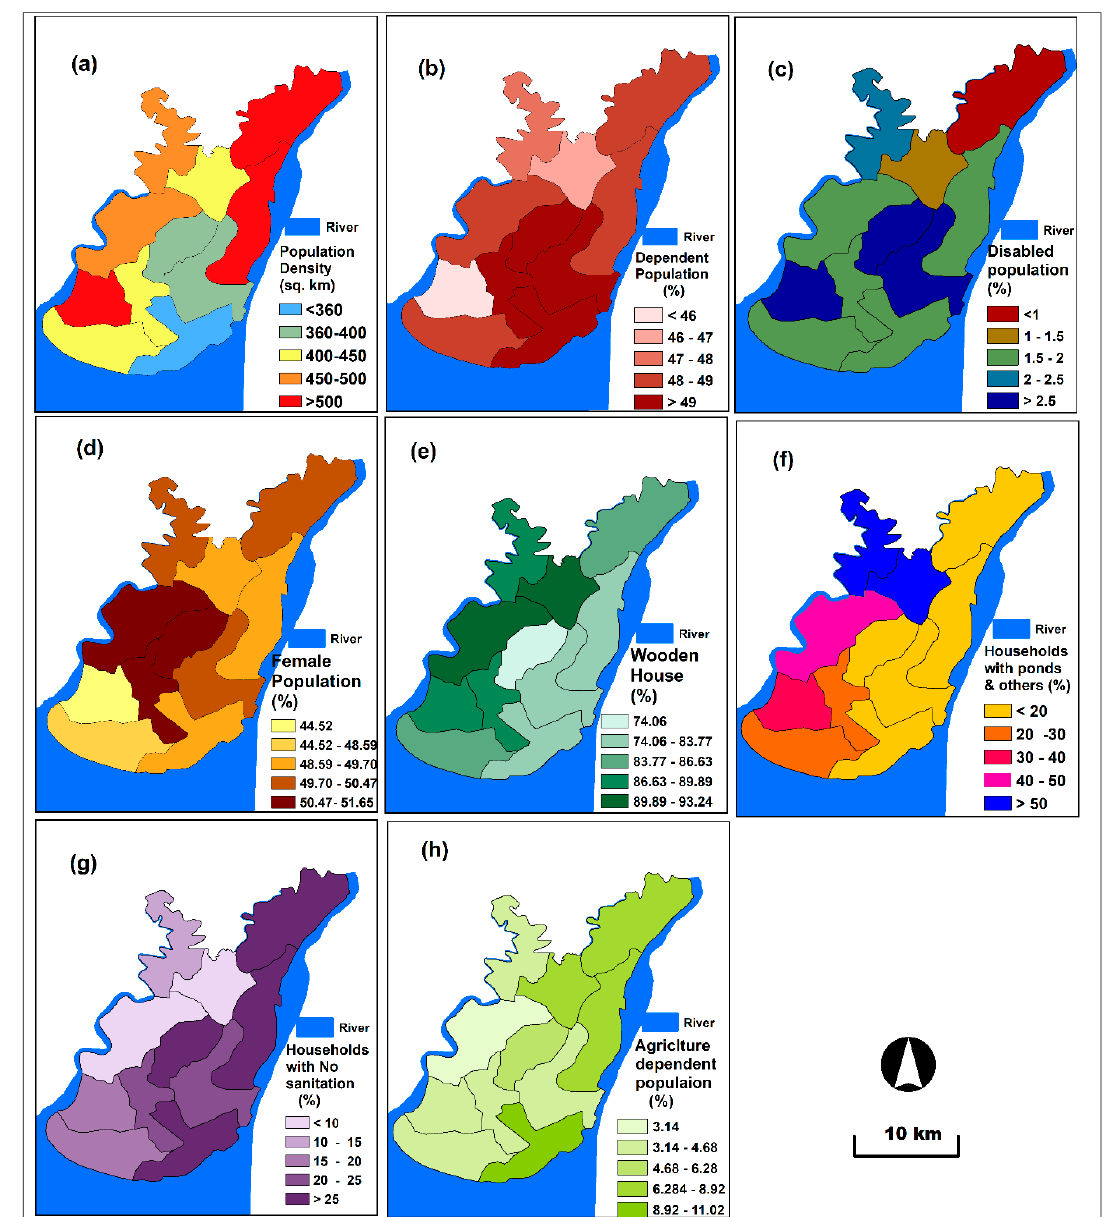
Figure 4. Social vulnerability criterion layers: ( a ) population density, ( b ) dependent population, ( c ) disabled population, ( d ) female population, ( e ) wooden house, ( f ) households with ponds and others, ( g ) households with no sanitation, ( h ) agriculture-dependent population.